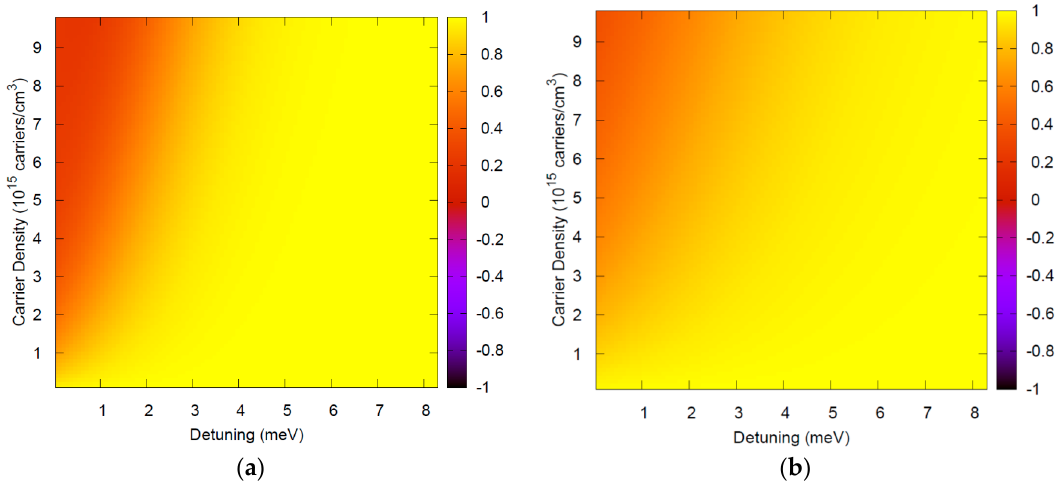
Figure 1. FF ( ω , ω (cid:48) ) , the term in curly braces in Equation (6) which has been approximated by FF ( ω , ω (cid:48) ) ≈ 1, evaluated at (cid:125) ω = E g for bulk GaAs at low temperatures, where the dephasing is typically small Γ λ . In this case, only a small range of detunings ω − ω (cid:48) contribute to the integral in Equation (4). Thus the range chosen in the x -axis, from zero to approximately twice the exciton binding energy (2 e 0 ), is even larger than necessary. ( a ) T = 10 K; ( b ) T = 20 K. Low temperature luminescence is typically performed with a small density of injected carriers.